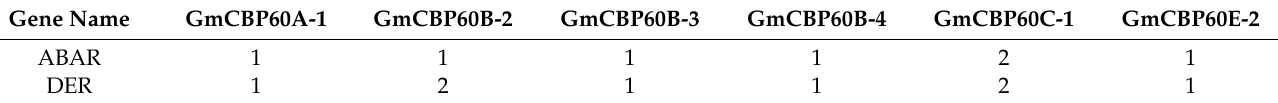
Table 1. Identify the number of having both ABAR and DER cis-acting in the promoter of six GmCBP60 genes.